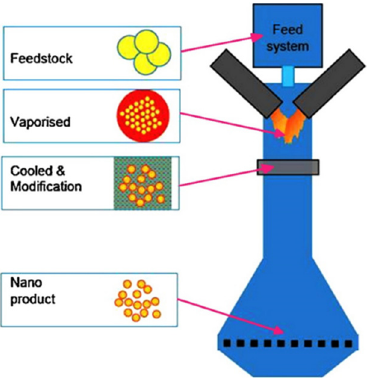
Figure 2. Schematic diagram of Tesima TM plasma process. Reproduced with permission from Ren et al., International Journal of Antimicrobial Agents ; published by Elsevier, 2009. [47].